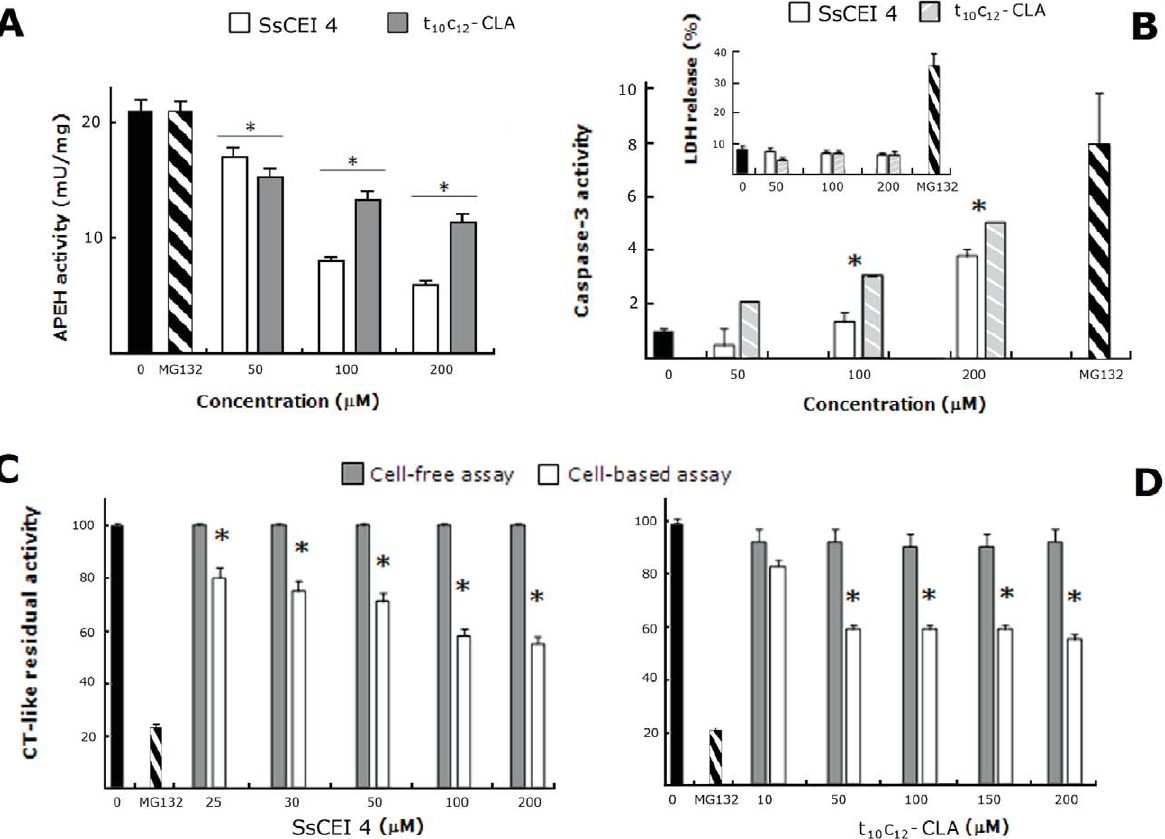
Figure 3. Down-regulation of the proteasome/APEH enzyme system by the SsCEI 4 and t 10 c 12 -CLA in Caco-2 cells. APEH activity was measured in Caco-2 cells incubated with 50 m M, 100 m M and 200 m M SsCEI 4 (white bars) or t 10 c 12 -CLA (gray bars) for 48 h (A). Proteasomal CT-like activity was measured in cell-free system (a partially purified proteasome fraction from differentiated Caco-2 cells, gray bars) and in Caco-2 cells (white bars) treated with increasing concentrations of SsCEI 4 (C) or t 10 c 12 -CLA (D). Caspase-3 activities and LDH release were measured upon 48 h incubations of Caco-2 cells with increasing concentrations of SsCEI 4 (white bars) and t 10 c 12 -CLA (striped grey bars) (B). The cytotoxic effect of the different treatments was evaluated by measuring the LDH release in the culture media (B insert). Cell-free protein mixtures, or Caco-2 cell cultures, treated with DMSO alone (black bars) or with MG132 (10 m M) (striped black bars) were used as positive controls. The data are expressed as means 6 SD. *Significantly different (P , 0.005) from respective controls.